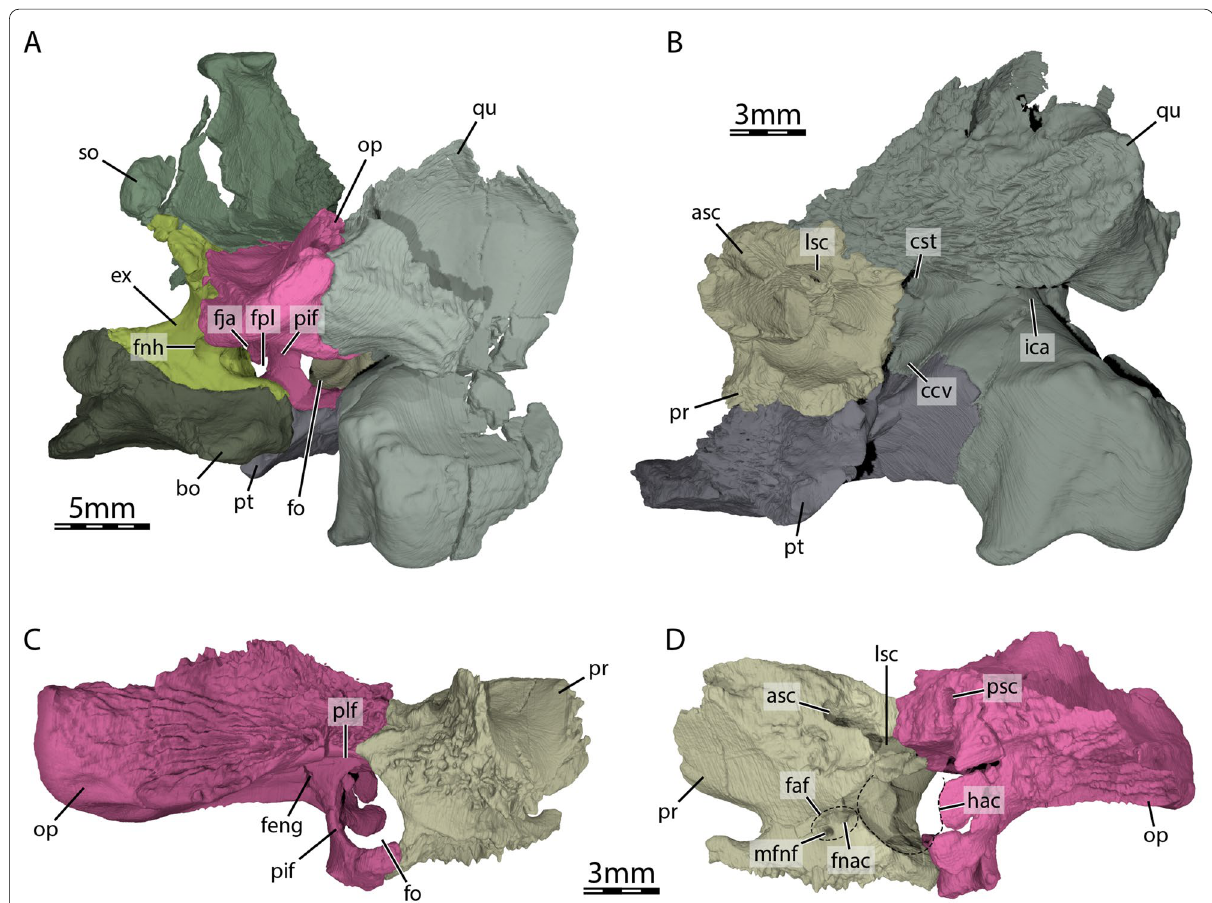
Fig. 8 Three-dimensional renderings of the cavum acustico-jugulare and the inner ear capsule of UCM 53971. A Posterolateral view of the basicranium and right cavum acustico-jugulare, B posterior view of right prootic, pterygoid, and quadrate, C lateral view of right prootic and opisthotic, and D medial view of right prootic and opisthotic. asc anterior semicircular canal, bo basioccipital, ccv canalis cavernosus, cst canalis stapedio-temporalis, ex exoccipital, faf fossa acustico-facialis, feng foramen externum nervi glossopharyngei, fja foramen jugulare anterius, fnac foramen nervi acustici, fnh foramen nervi hypoglossi, fo fenestra ovalis, fpl fenestra perilymphatica, hac hiatus acusticus, ica incisura columella auris, lsc lateral semicircular canal, mfnf medial foramen nervi facialis, op opisthotic, pif processus interfenestralis of the opisthotic, plf perilymphatic fossa, pr prootic, psc posterior semicircular canal, pt pterygoid, qu quadrate, so